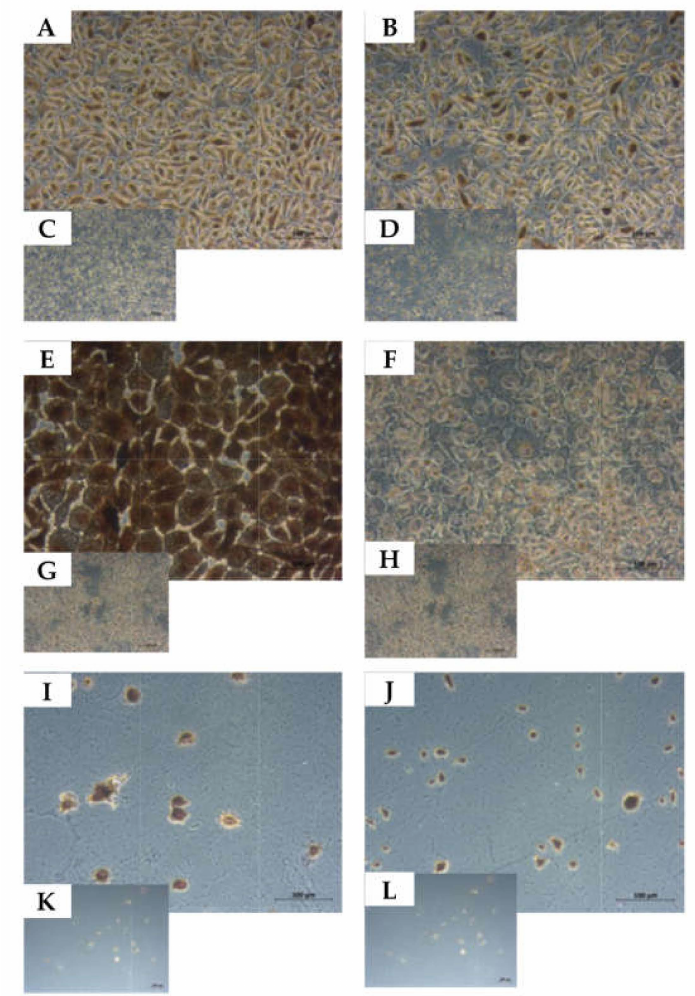
Figure 6. Detection of urothelial versus mesenchymal antigens on normal urothelial cells and UM- UC-10. Normal urothelial cells ( A – D ), UM-UC-10 ( E – H ), and UM-UC-13 ( I – L ) were stained with AE1/AE3 to detect cytokeratins as markers for urothelial cells ( A , E , I ) or with anti-vimentin antibodies to detect this mesenchymal lineage marker ( B – J ). Omitting the primary antibodies served as controls,